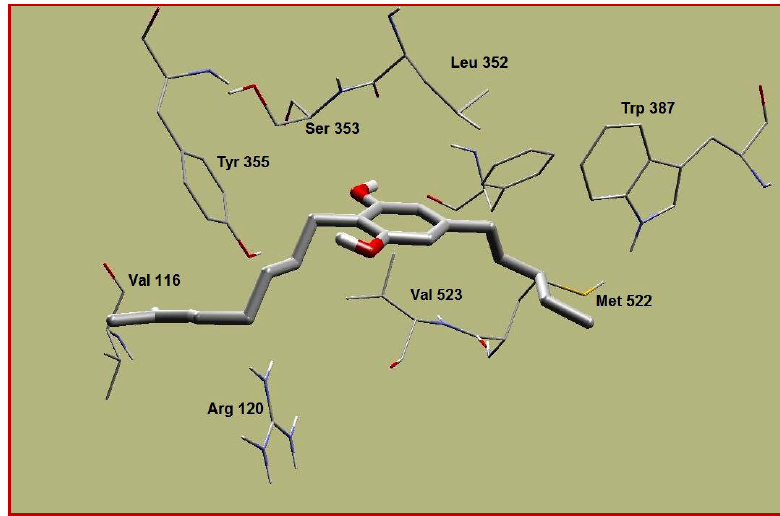
Figure 3: A closer view of molecular interactions of cannabigerol with important amino acid residues inside binding pocket of COX-2